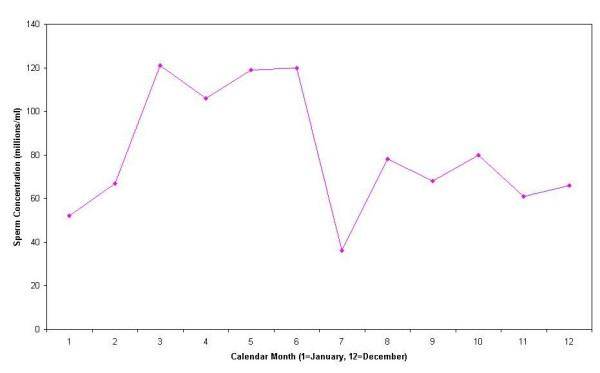
Median sperm concentration by month.